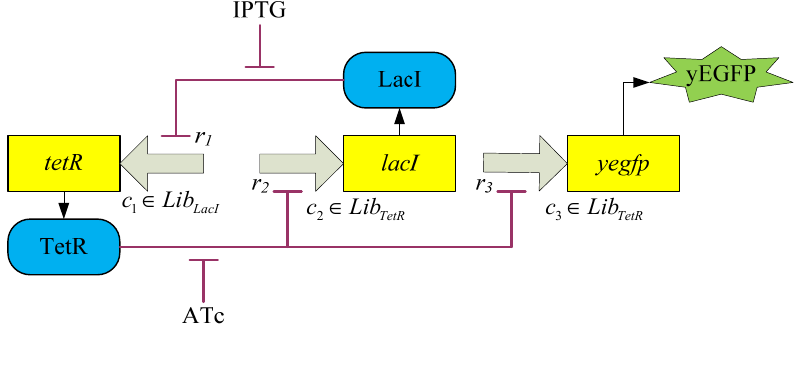
Figure 11. Synthetic gene circuit topology: simple toggle switch. The regulatory protein TetR, which is induced by ATc, inhibits the transcription of lacI by binding promoter c . 2 TetR also inhibits transcription of yegfp by binding promoter c to repress the expression of 3 the fluorescent protein yEGFP. The protein LacI, which is induced by the inducer IPTG, inhibits the transcription of tetR by binding promoter c . The gene circuit has two distinct 1 stable states, and can reversibly switch between them by changing the inducers ATc and IPTG. If an adequate promoter set c = [ c , c , c ] is selected from corresponding promoter 1 2 3 libraries, then yEGFP can be used to track the desired behaviors generated by a reference model. In the reference model, c is selected from the LacI-regulated promoter library, and c 1 2 and c are selected from the TetR-regulated promoter library in Table 2 ( i.e. , c , ∈ Lib 3 1 LacI , c c ∈ Lib 2 3 TetR